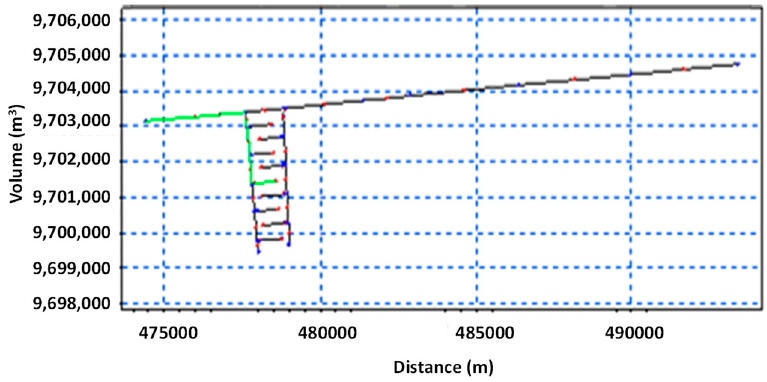
Figure 12. Cross section of channel models for sediment movement in channels tertiary tc-5 there is a sluicegate.